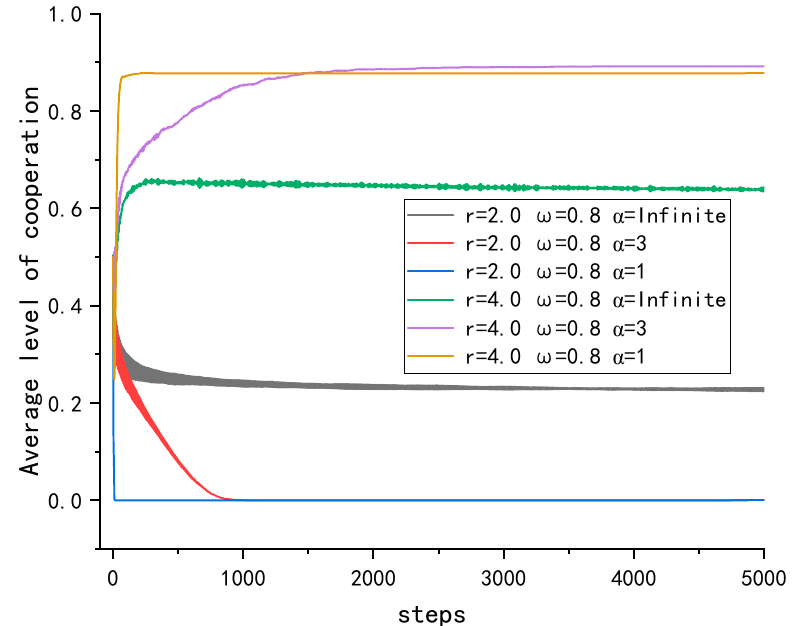
Figure 13. Evolution of mean cooperation level over time for different combinations of r and α at ω = 0.8.